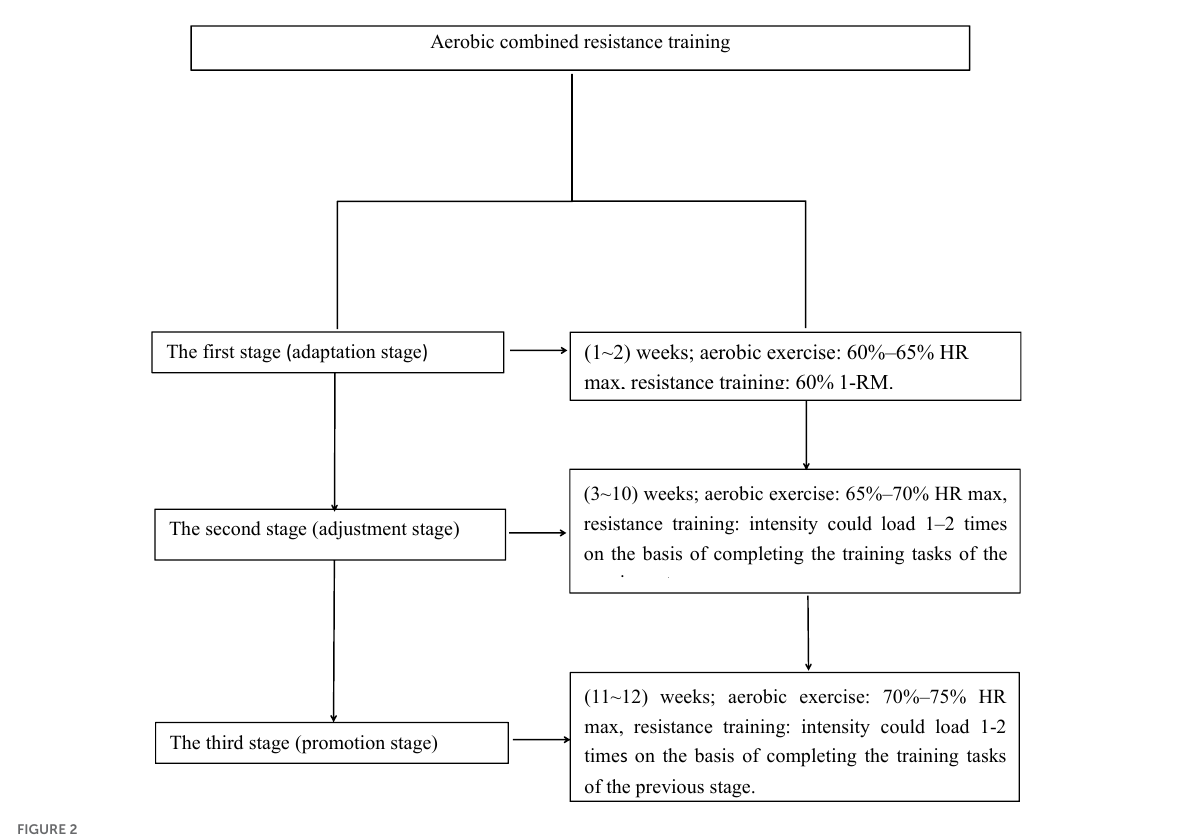
FIGURE2 Exercise intervention flow chart.